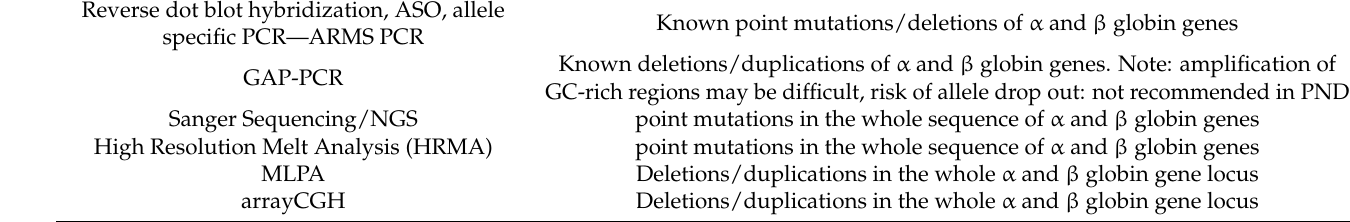
Table 11. Types of mutation identifiable by different DNA analysis techniques [3,26]. Reverse dot blot hybridization, ASO, allele